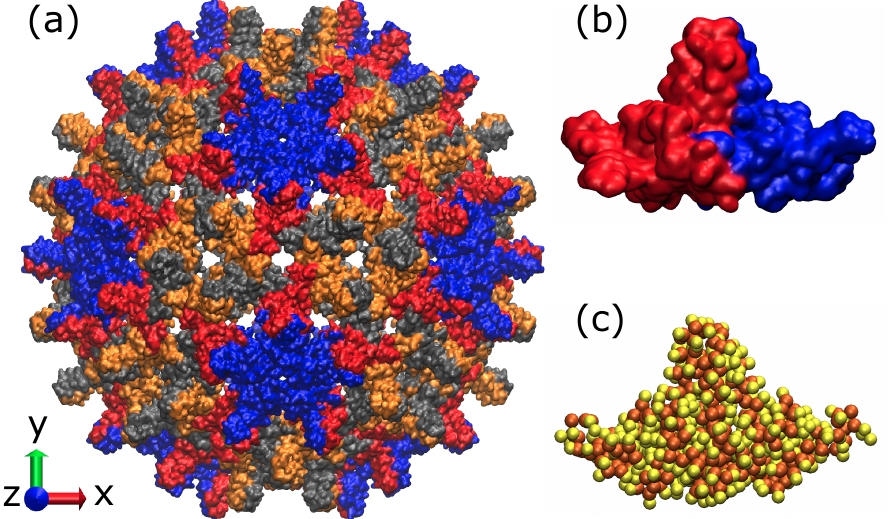
Figure 1. Atomistic reference structure of ( a ) HBcAg T = 4 capsid (composed of 120 dimers/240 monomers) and ( b ) HBcAg 2 dimer based on PDB 6HTX [56] and PDB 1QGT [43]. ( c ) The coarse-grained Martini representation after representative